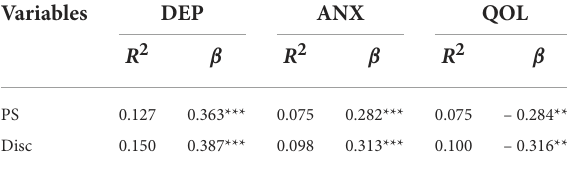
TABLE 2 Linear regression showing the effect of perceived stigma and discrimination on depression, anxiety, and quality of life.